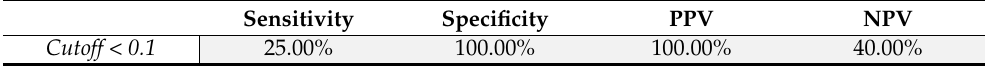
Figure 3. Salivary flow demonstrated excellent accuracy in identifying Group A membership, with an AUC of 0.915. Table 4. Specificity, sensitivity, PPV and NPV of uSFR cut-off of <0.1